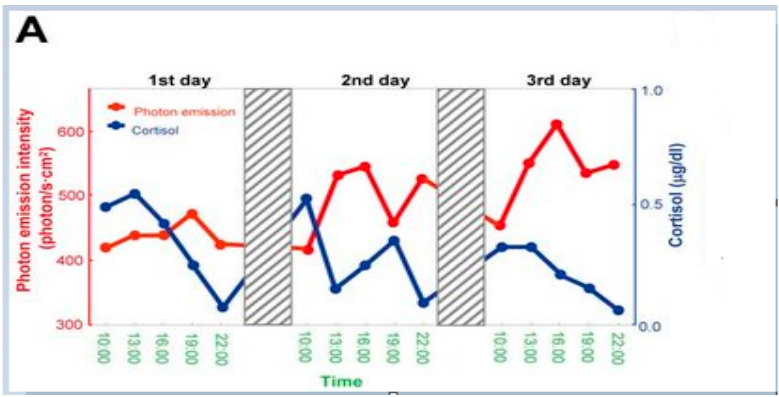
Figure 8. Temporal variation in biophoton intensity and cortisol over 3 days.